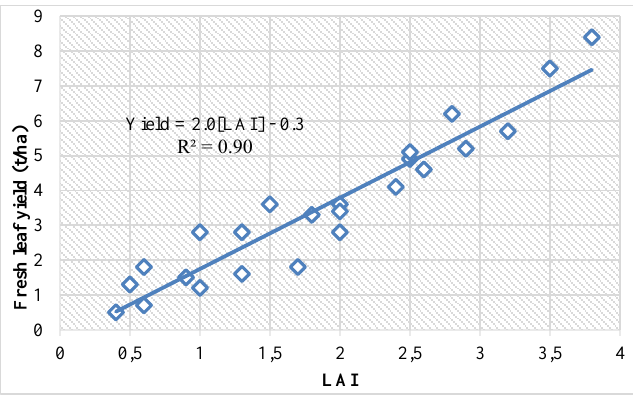
Figure 10a. Regression analysis between fresh rape leaf yield and LAI (2014)